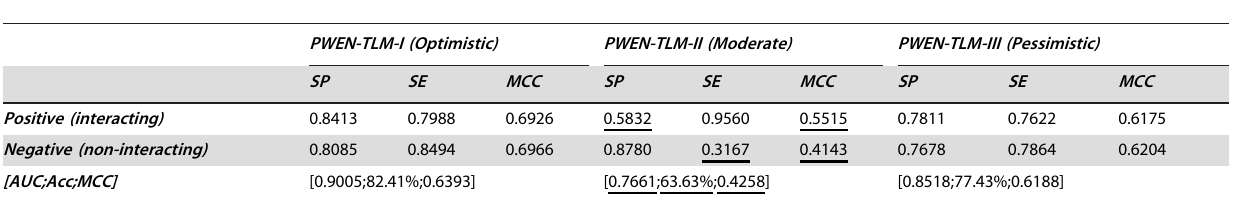
Table 2. Cross validation performance estimation on dataset S2 .